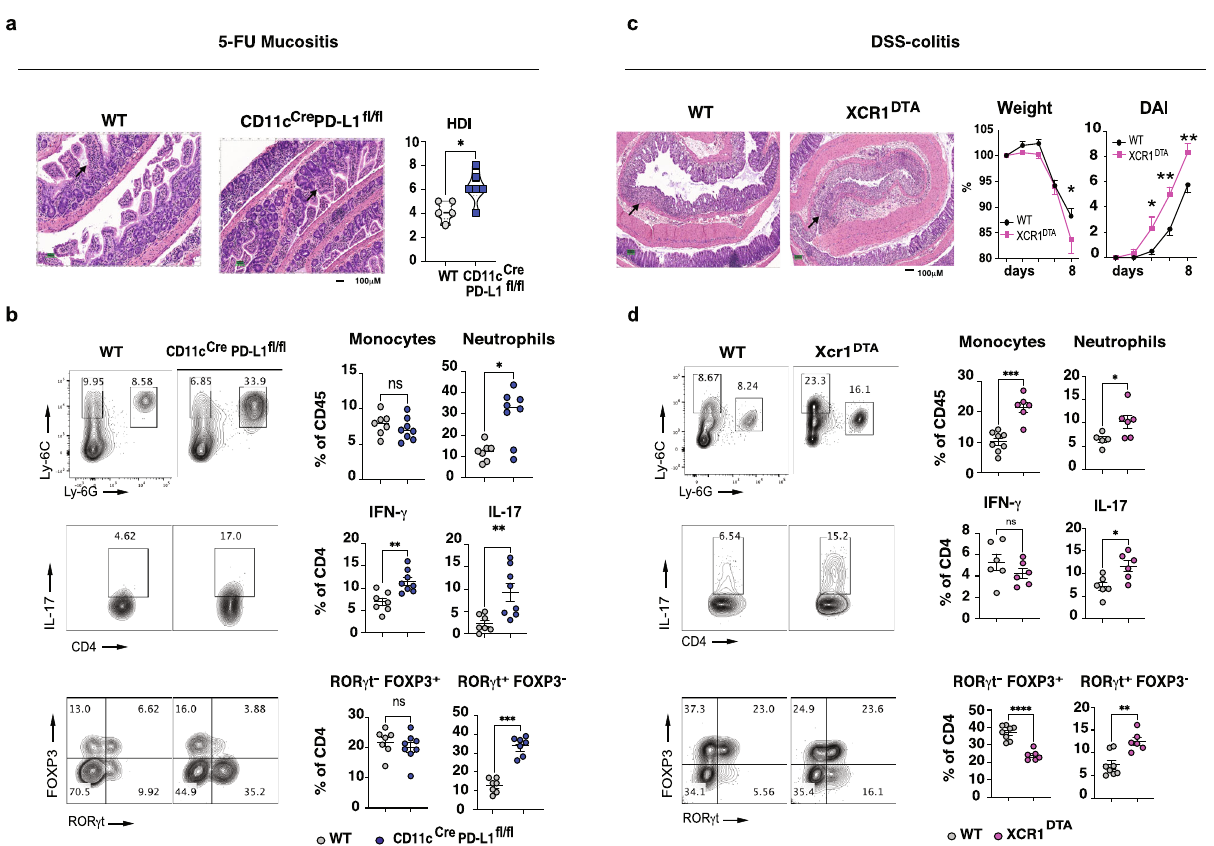
Fig. 5 PD-L1 + and XCR1 + DCs are region-speci fi c regulators of gut homeostasis. a Histological damage index (HDI) and Hematoxylin and Eosin (H&E) staining from distal jejunum from littermate controls and CD11c Cre xPd-l1 fl ox/ fl ox mice after 72 h of 5-FU administration (10X); N = at least fi ve * p = 0.032. b Flow cytometry representative dot plots and quanti fi cation of LP cells (monocytes, neutrophils, IL-17-producing CD4 T cells, Treg cells, and ROR γ t expressing CD4 T cells) isolated from upper small intestine (duodenum + jejunum) of CD11c Cre xPd-l1 fl ox/ fl ox mice and littermate controls. Unpaired two- tailed Student ’ s t test * p = 0.01, ** p = 0.002, ** p = 0.007 (IL-17), *** p = 0.0006. c Weight loss * p = 0.041, Disease Activity Index (DAI) * p = 0.048, ** p = 0.0015, ** p = 0.0029 (day8) and H&E from the colon in DSS-treated littermate controls and XCR1 DTA mice (×10), N = 5. d Flow cytometry (FC) representative dot plots and quanti fi cation of LP cells as shown in b isolated from colonic LP cells from XCR1 DTA mice and littermate controls. Boxes and dots represent mean ± SEM. * p = 0.044, * p = 0.014 (IL-17), ** p = 0.001, *** p = 0.0001, **** p < 0.0001. Non-parametric Student ’ s t test with unpaired two-tailed Mann – Whitney post test was used for histological analysis, unpaired two-tailed Student ’ s t test was used for FC and two-way-ANOVA followed by Sidak post hoc test for multiple comparisons was used for DAI and weight loss analysis. Experiments were performed independently in duplicate. Source data are provided as a Source Data fi le. Wild-type